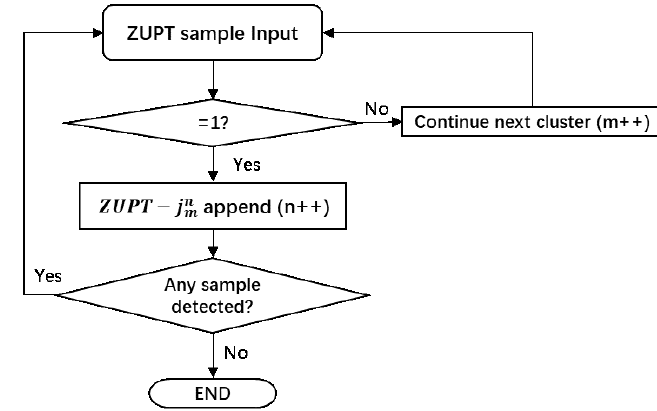
Figure 5. Calculation of ZUPT